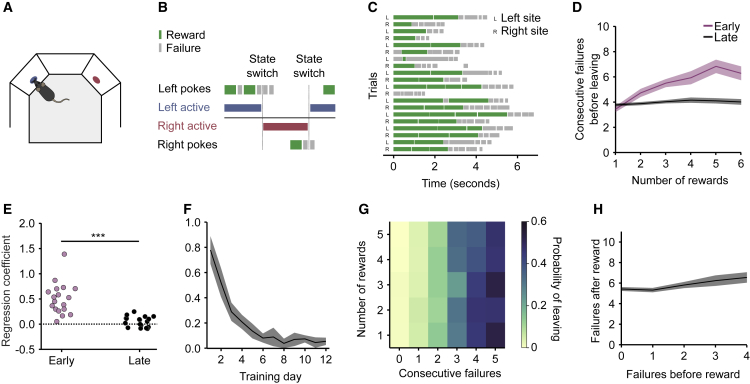
Mice Accumulate Inferred Evidence for State Switches and Not Site Value(A) Schematic of rodent task. Mice shuttle back and forth between two reward sites to obtain water rewards.(B) Example sequence of pokes. Pokes in the correct site can be rewarded or not, whereas pokes in the incorrect site are never rewarded. Following a state switch, the animals need to travel to the other site to obtain more rewards.(C) Example behavior: sequence of poke bouts (i.e., trials) with rewards in green and failures in gray.(D) Consecutive failures before leaving as a function of reward number in early training (days 1 to 3, purple) compared with late training (days 10 to 12, black). Solid line represents mean and sha.(E) Slope coefficient in ConsecutiveFailures∼1+RewardNumber for early training and late training. Slope coefficient is higher in early trials, likelihood ratio test on linear mixed-effect model ConsecutiveFailures∼1+RewardNumber+Early+RewardNumber&Early+(1|MouseID) versus a null model with no interaction: p < 1e−10, n = 18 mice (see STAR Methods for a description of the formula notation).(F) Evolution of reward number coefficient across days. Solid line and shaded area represent mean and SEM across animals.(G) Probability of leaving as a function of number of rewards and consecutive failures in late training.(H) Failures after reward as a function of failure before reward in trials with only one reward in a more difficult protocol. Solid line and shaded area represent mean and SEM across animals.See also Video S1.Video S1. Murine Foraging Task, Related to Figure 2An example mouse performing the hidden-state foraging task inside a behavioral box, viewed from the top